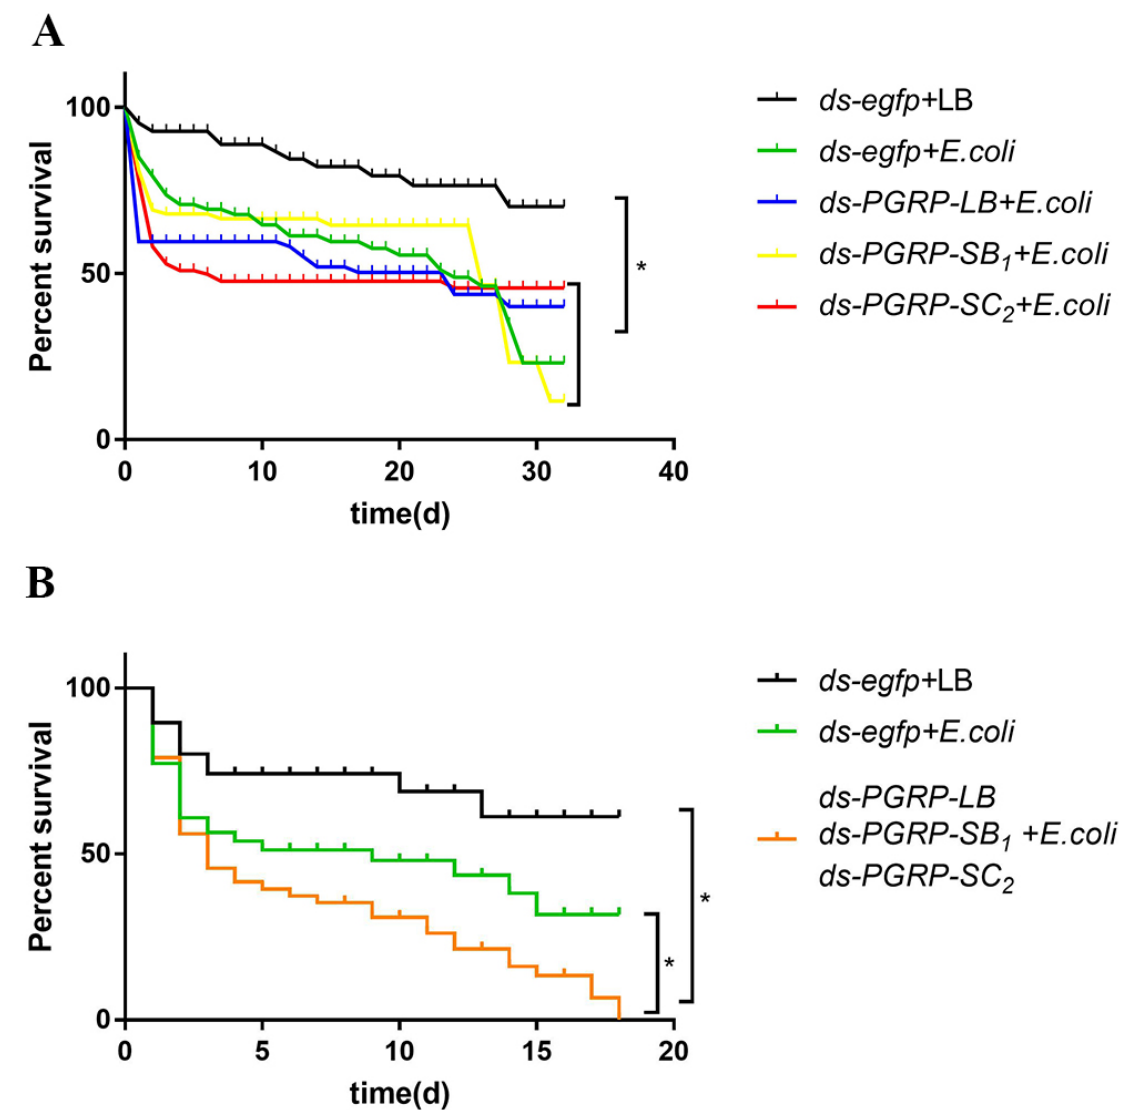
Figure 7. Survival rate of B. dorsalis after BdPGRPs RNAi followed by E. coli infection. ( A ) Three BdPGRPs were knocked down separately. ( B ) Three BdPGRPs were knocked down at the same time. Statistical analysis was based on Log-rank (Mantel–Cox) test (* p < 0.05).